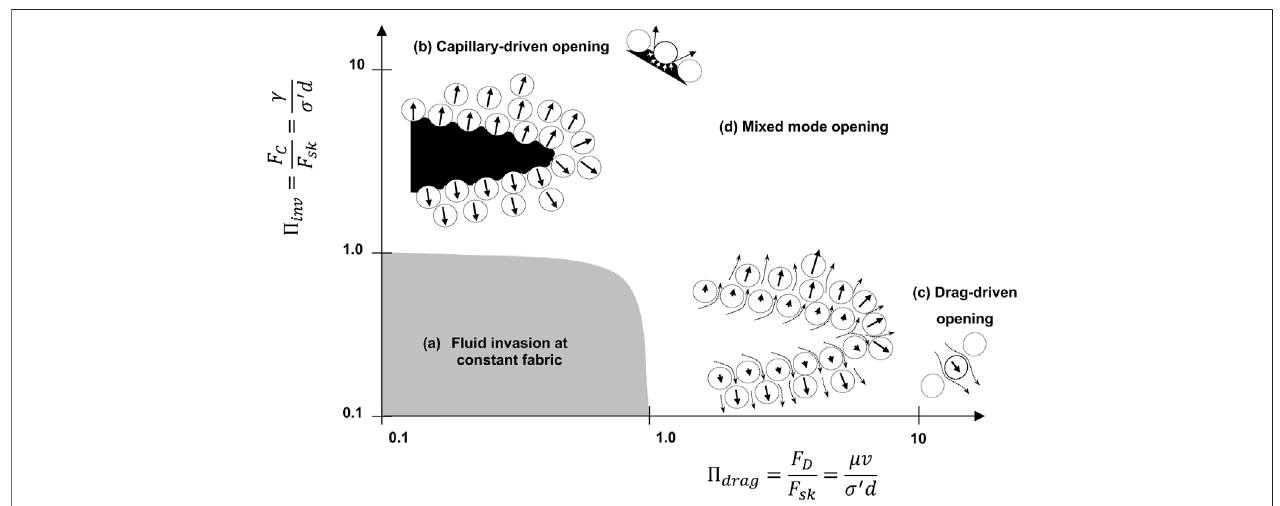
FIGURE9 | Grain-displacive open-mode discontinuities. (A) Fluid invasion withoutfabric changes. (B) Capillary-driven opening: surface tension and thedifference in fl uidpressuresacrossthe fl uidinterfaceareresponsiblefortheresultingparticleforces. (C) Drag-drivenopening:dragforcespushparticlesandaccumulateawayfrom the opening. (D) Mixed mode